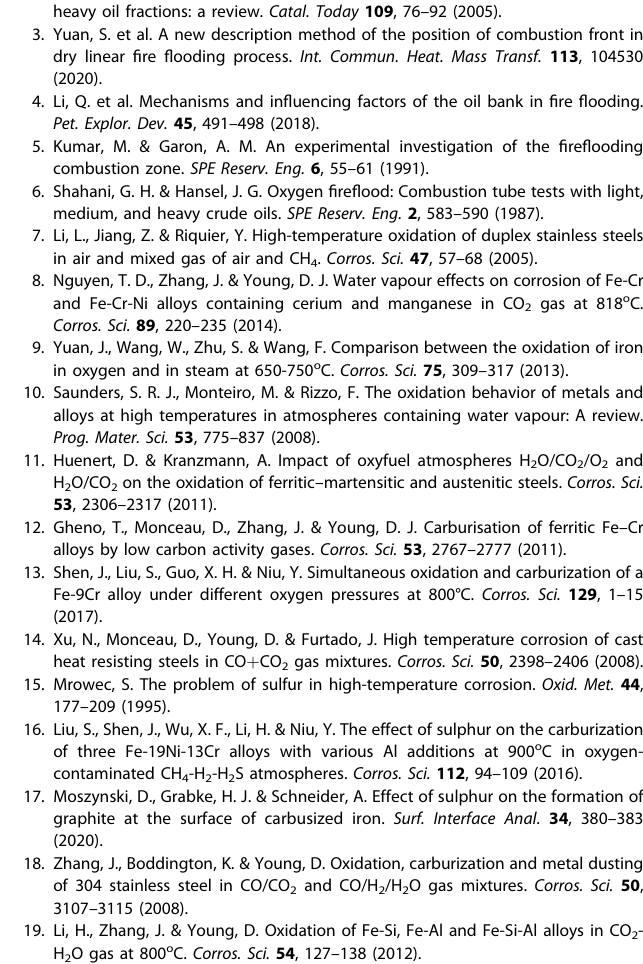
was started. After appropriate time intervals of 2 min, the samples were removed from the furnace, cooled in air, and then weighed using an electronic balance with a sensitivity of 0.01 mg. The samples were cleaned using deionized water before weighing. To ensure reliability, each group